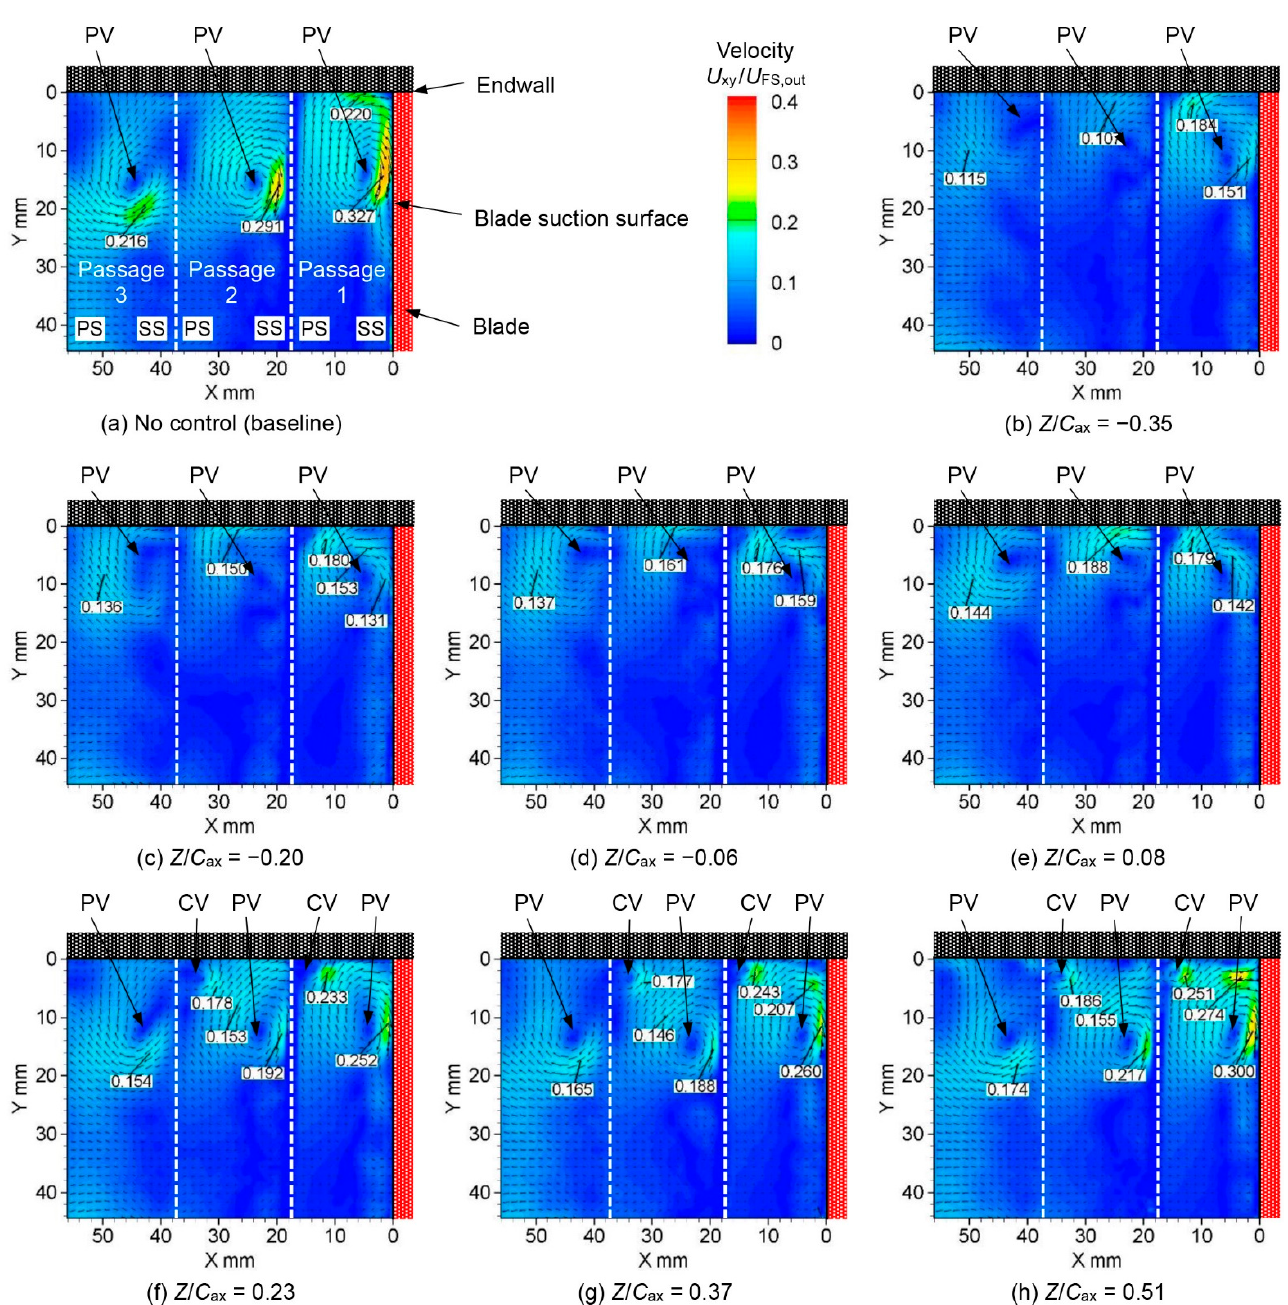
Figure 7. Velocity distributions of secondary flow at the outlet of the linear turbine cascade at vari- ous plasma actuator locations (Re out = 1.8 × 10 4